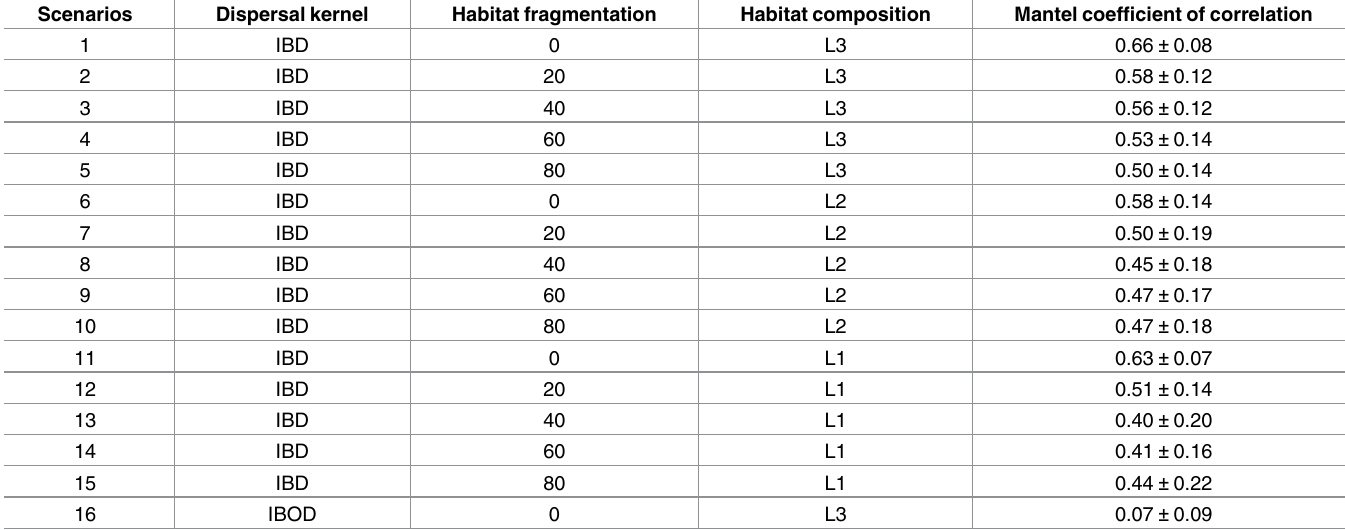
Table 4. Summaryof all scenarios tested in this study and the corresponding correlations between the simulated and observed genetic structure.